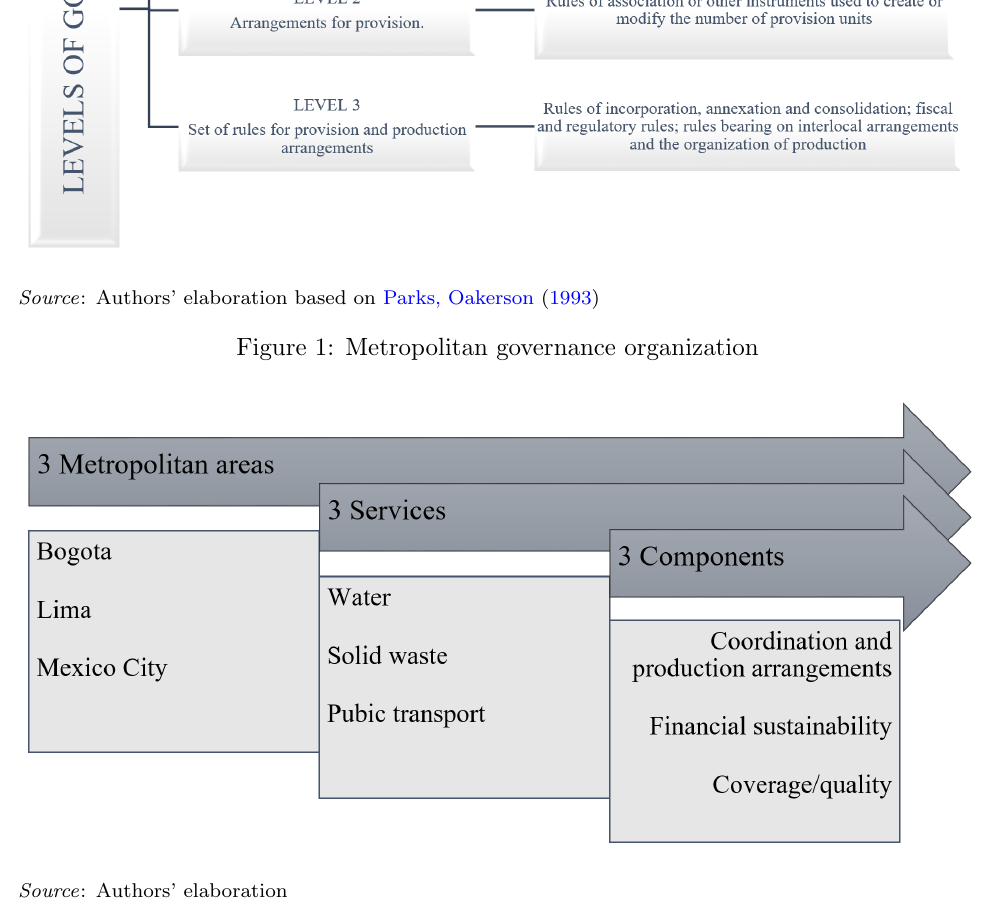
Figure 2: Components of the 3 x 3 x 3 model of